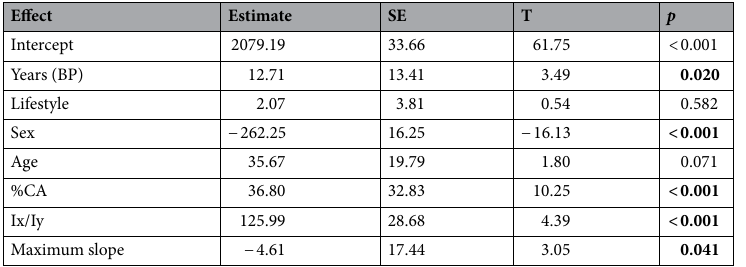
Table 1. Results of the generalized additive mixed model (GAMM) calculated for Homo sapiens a . SE standard error, T value of the t test, Age mean age of each individual, %CA percent of cortical area in a cross section, Ix/ Iy ratio of Ix and Iy, R 2 = 0.229. a Side of the body was used as a random effect with SD = 13.54. Bold indicates statistically significant at p < 0.05.